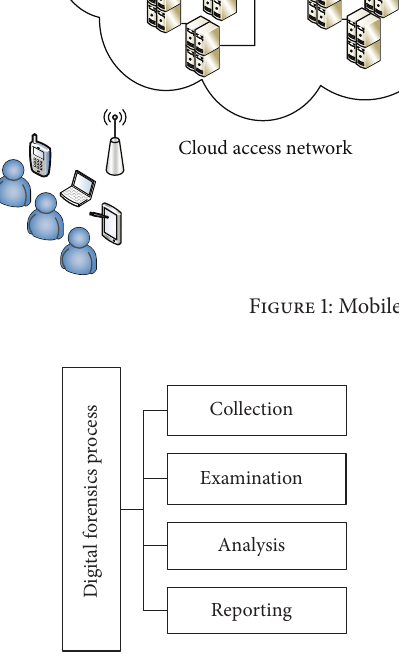
Figure 2: Digital forensics process